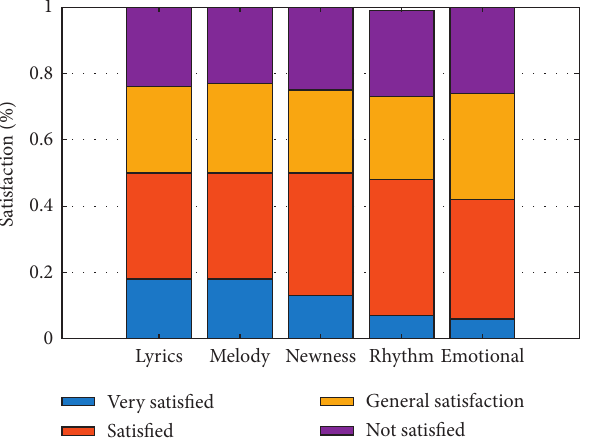
Figure 7: Personalized music recommendation satisfaction analysis chart of data